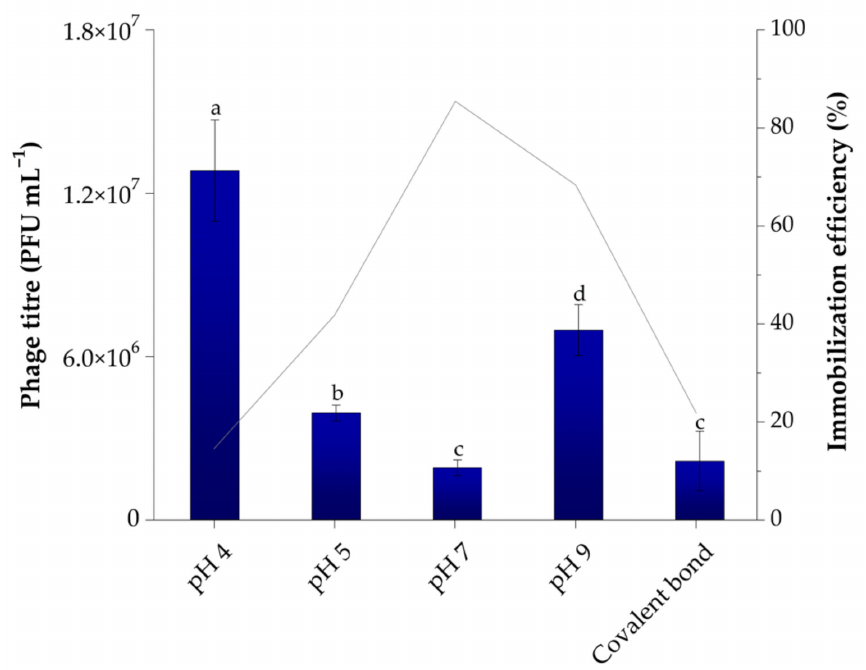
Figure 3. Phage activity (columns) and immobilization efficiency (solid line) of P100–MBs (MicroMod ® , 32 µ g) modified with a 10 9 PFU mL − 1 phage solution at the indicated pH values. Error bars denote the standard deviation from the mean of three independent experiments. Different lowercase letters represent significantly different mean values ( p <